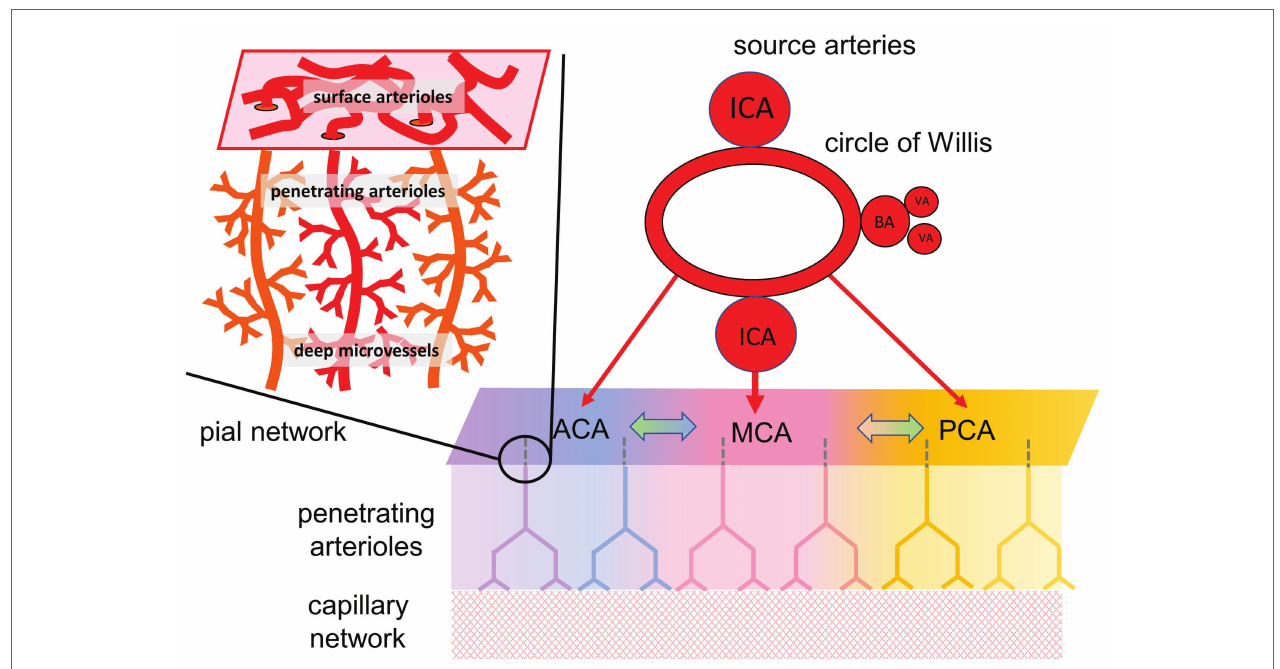
FIGURE 1 | Organization of cerebral blood flow (CBF) and collateral blood flow. CBF is supplied by four extracranial arteries originating from the aortic arch and subclavian arteries, the internal carotid arteries (ICA), and the vertebral arteries (VA). The latter joining to form the basilar artery (BA). Intracranially, these arteries anastomose around the circle of Willis, and separate into the major intracranial vessels perfusing each hemisphere: the anterior cerebral artery (ACA), middle cerebral artery (MCA), and posterior cerebral artery (PCA). Although there are multiple anastomoses between the major cerebral vascular territories, the blood supply to each territory, in baseline states, comes predominantly from its overlying artery (illustrated by color coding). In the case of partial or complete blockage of one of the cerebral arteries, the availability of blood flow depends on the ability to recruit collateral pathways. Figure modified from Fisher et al.